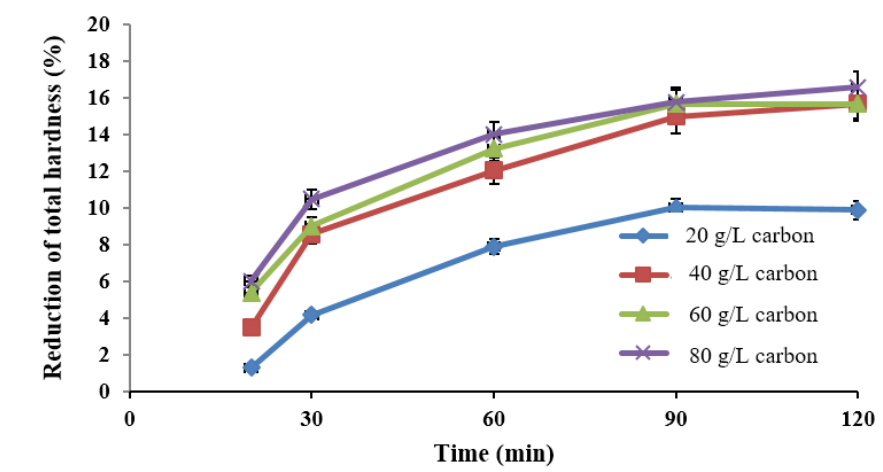
Figure 7. The effect of contact time on reducing total hardness (%) of ( a ) drinking water and ( b ) groundwater by different concentrations of activated carbon (g/L).